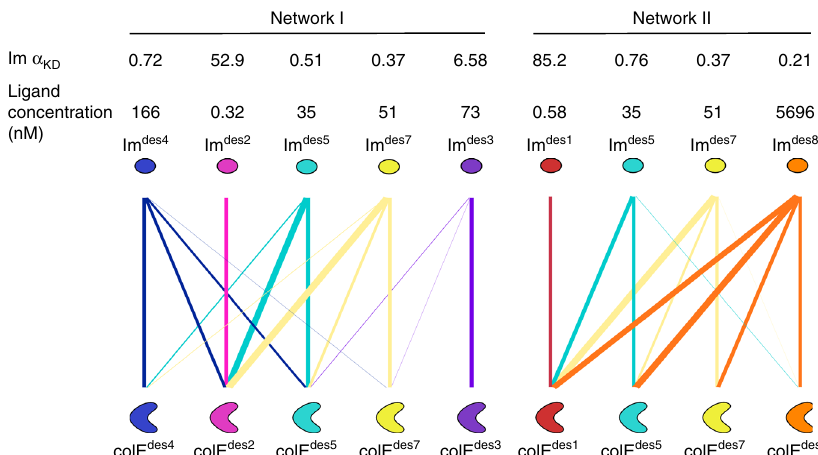
Fig. 8 Diverse interaction networks among the designed pairs. The network speci fi city of each Im for its cognate colE ( α K D ; Eq. (3)) is noted on top. The width of the line that connects each colE/Im pair is proportional to the steady-state fractional occupancy of the bound state of this colE by the Im (Eq. (2)). Interactions with fractional occupancy <1% are not shown. Network I: a complex network architecture exhibiting both high speci fi city (Im des2 ) and multispeci fi city (Im des7 ). Network II: Im des1 binds only its cognate colE; Im des5 binds two colE proteins; Im des7 binds three; and Im des8 binds to all colE proteins in the network, thereby exhibiting a hierarchical, “ Russian-doll ” like network architecture. Scripts for generating interaction networks between selected sets of designed pairs are provided in Supplementary Data 2 could be readily enhanced in the designed pairs by applying the automated, web-accessible Af fi Lib method. More generally, Af fi Lib may in some cases eliminate the reliance on tedious experimental af fi nity maturation in protein design and engi- neering studies 54,55 .